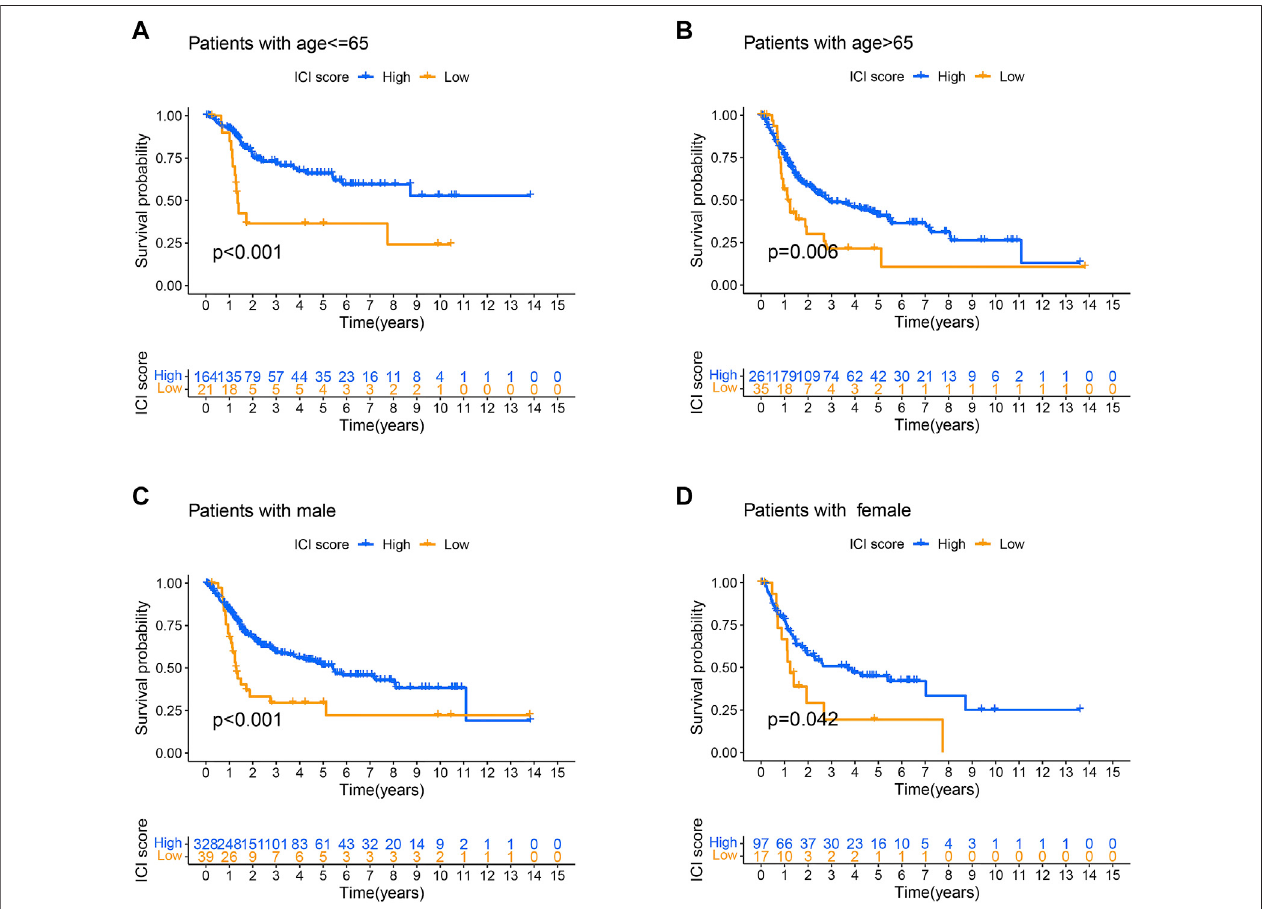
FIGURE 8 | Analysis of clinical features in high and low ICI score groups. (A – D) Survival time of patients with high and low ICI score groups in distinct clinical features: (A) age ≤ 65; (B) age > 65; (C) male patients; (D) female patients.